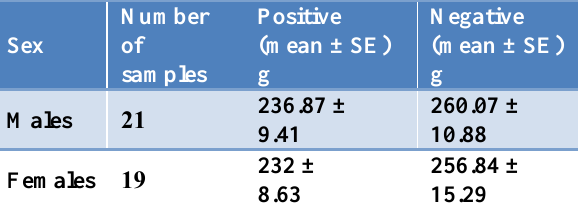
Table, 4: Effects of Eimeria spp infection in the body weight of both